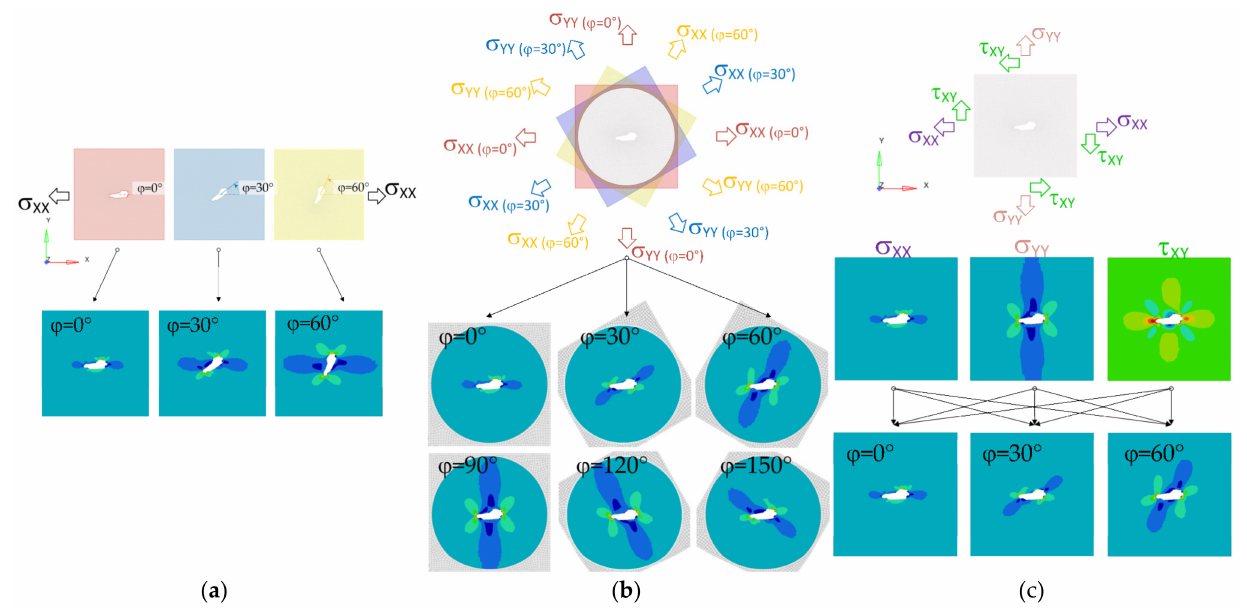
Figure 2. Principle methods of solution to obtain local stress and elastic strain energy density results for irregularly shaped defects under uniaxial loading with varying load vectors: ( a ) Individual load case study; ( b ) Sub-case approach; and ( c ) Transformation and superposition of basic load